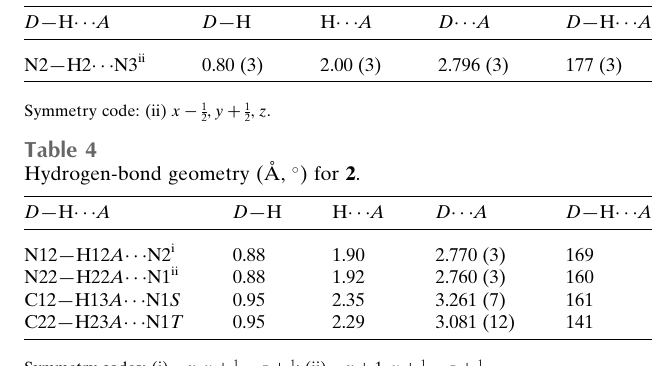
Table 3 Hydrogen-bond geometry (A˚ , (cid:5) ) for 1 .